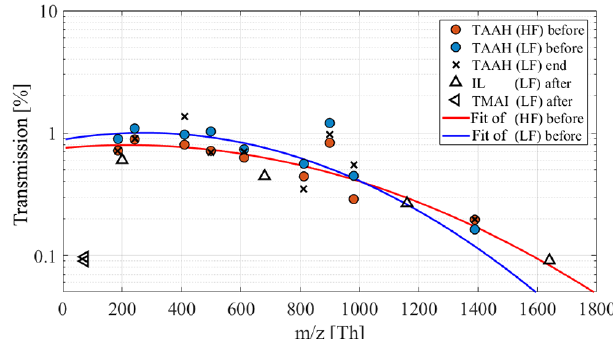
Figure 4. Transmission efficiency for low-fragmenting (LF) and high-fragmenting (HF) ion transfer settings of the ioniAPi-TOF for ions of different tetra-alkyl-ammonium-halides (TAAH) and an ionic liquid (IL); see Table 2. A Gaussian fit was used to obtain the transmission curves. Calibrations were done before the CLOUD campaign, in the end and after the campaign in